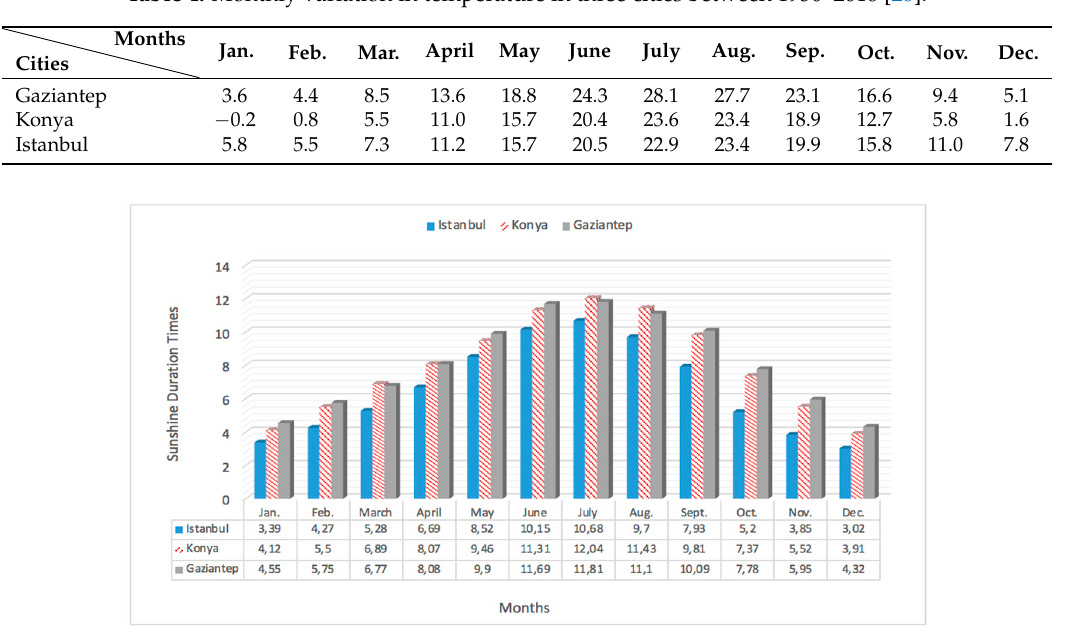
Figure 3. The annual sunshine duration times of Istanbul, Konya and Gaziantep [22].